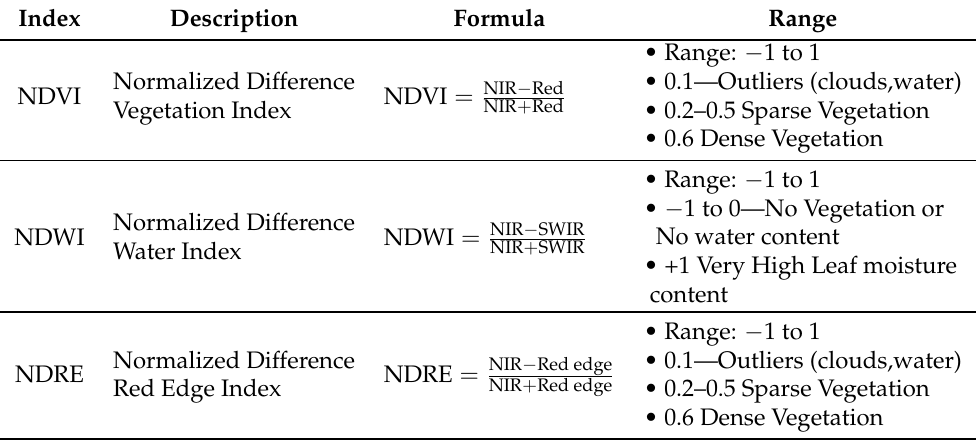
Table 2. Derived Index